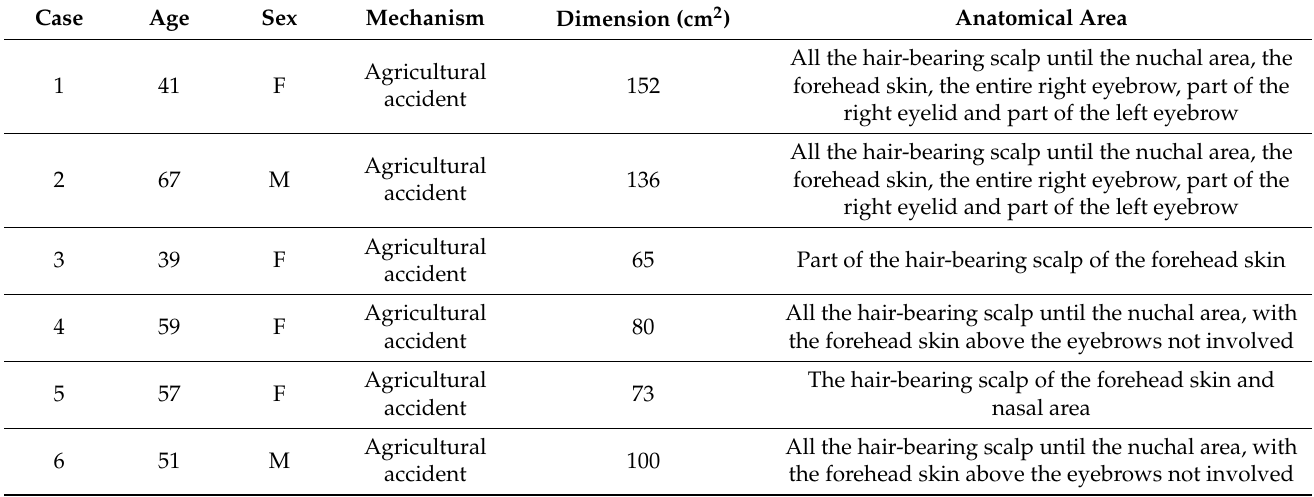
Table 1. General characteristics of the